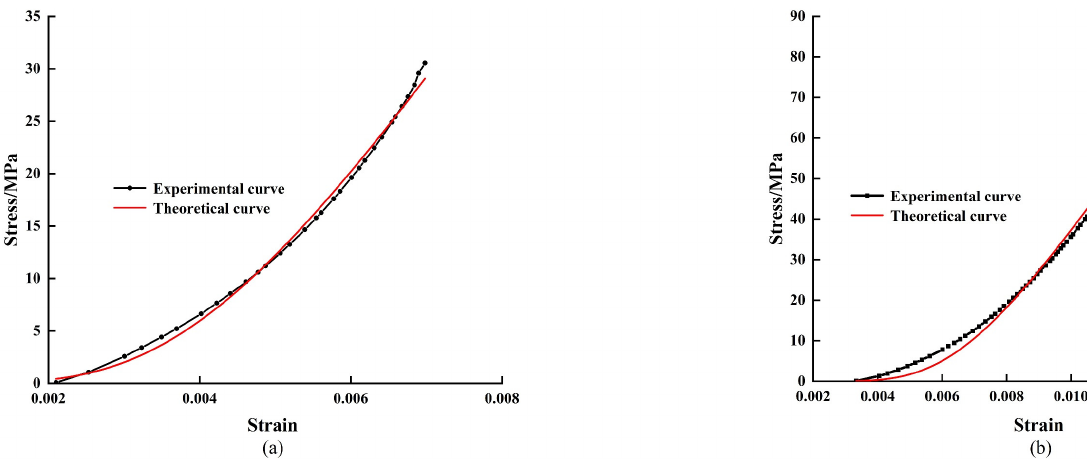
Figure 10. Unloading curve fitting: ( a ) 30 MPa. ( b ) 80 MPa.